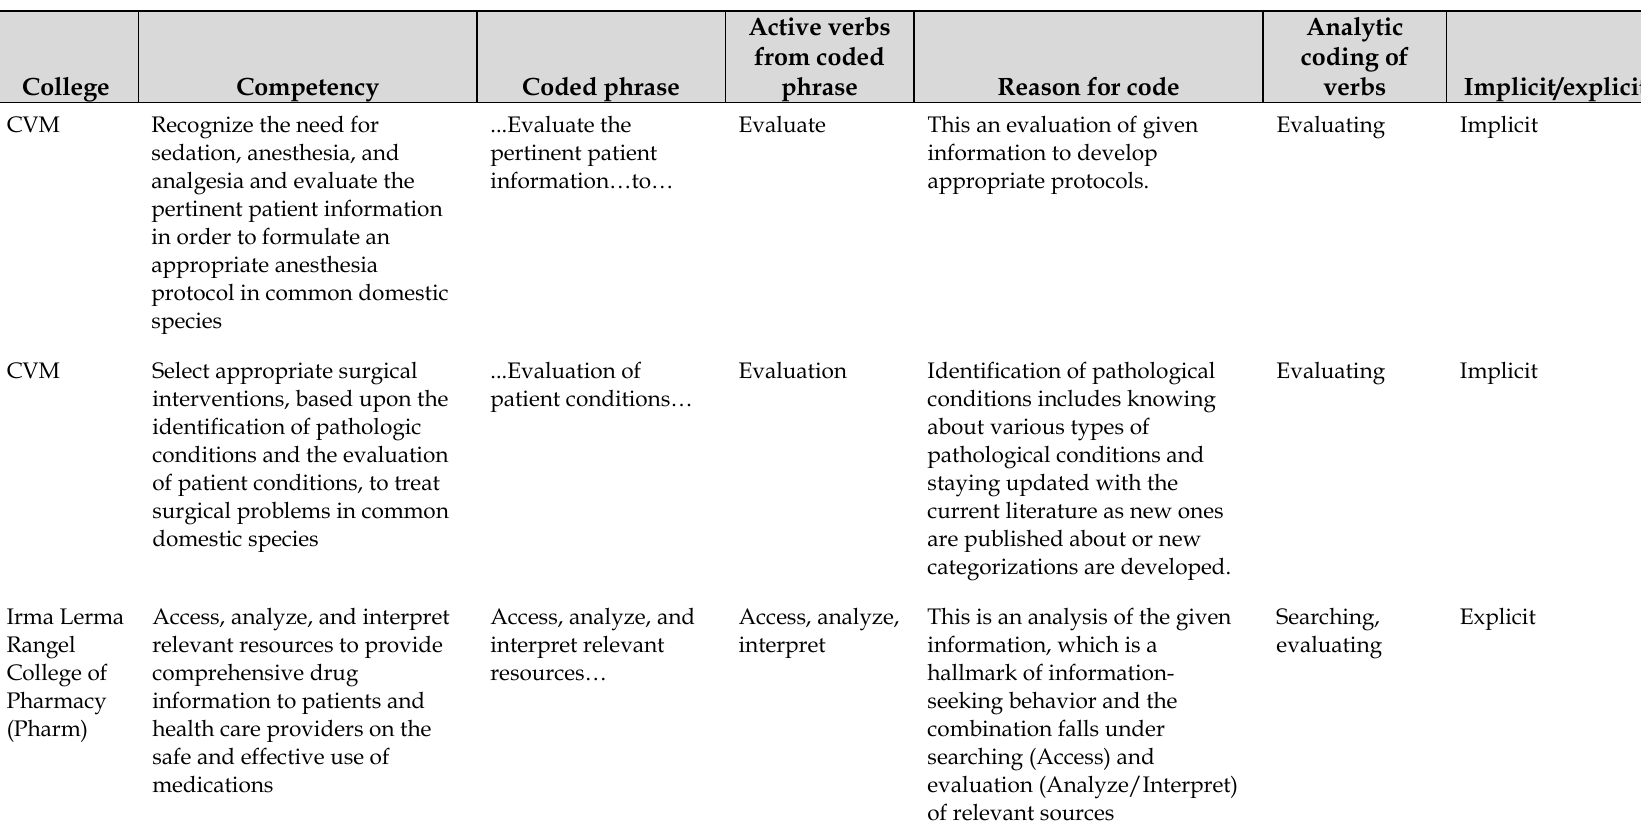
Table 2 Competencies with implicit or explicit information skills and behaviors